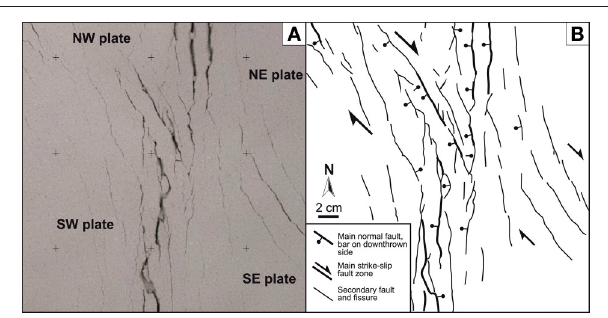
FIGURE 11 | (A) Photo of the experiment 4, made by moving westwards at differential velocities and amount the NW, SW, and SE plates, and keeping the NE plate fixed, plus a diffuse zone of strain across the whole rift (TFS). (B) Sketch of the photo with indication of the main and secondary faults and extensional fractures. In this case several other faults and extensional fractures developed east of the GF, mimicking the overall structure of the real TFS. The change in strike of the TFS structures southeast of the HFF–GF junction is related to the presence of a NW–SE right-lateral shear zone below the rift, and supports our interpretation of the HFF prolongation.